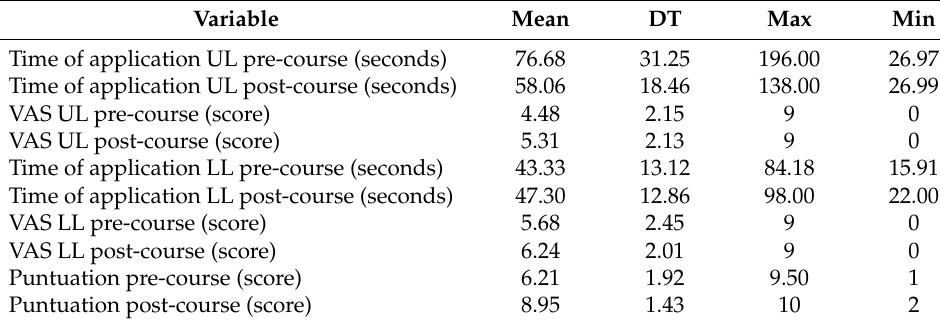
Table 1. Results of time, VAS, and test score